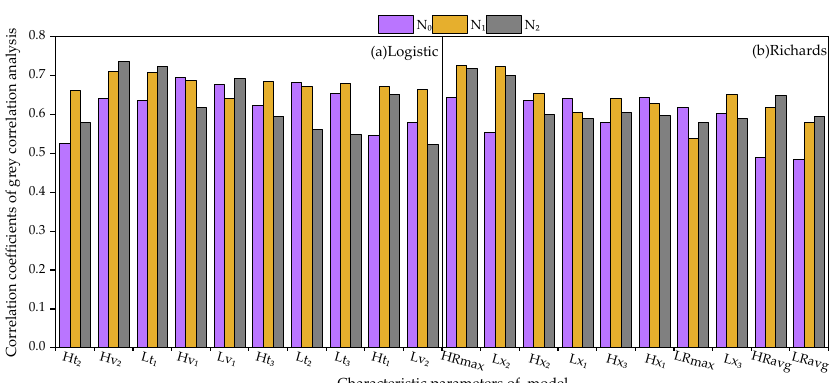
Figure 7. Grey correlation analysis of growth characteristic parameters and yield of tomato under N application rate treatments. N 0 , N 1 , and N 2 represent 0, 140, and 210 kg ha −1 N application rates, respectively. ( a ) is the growth characteristic parameters of Logistic model, and ( b ) is the growth characteristic parameters of Richards model.